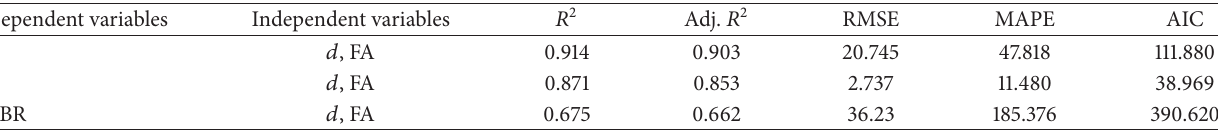
Table 6: Goodness-of-fit for